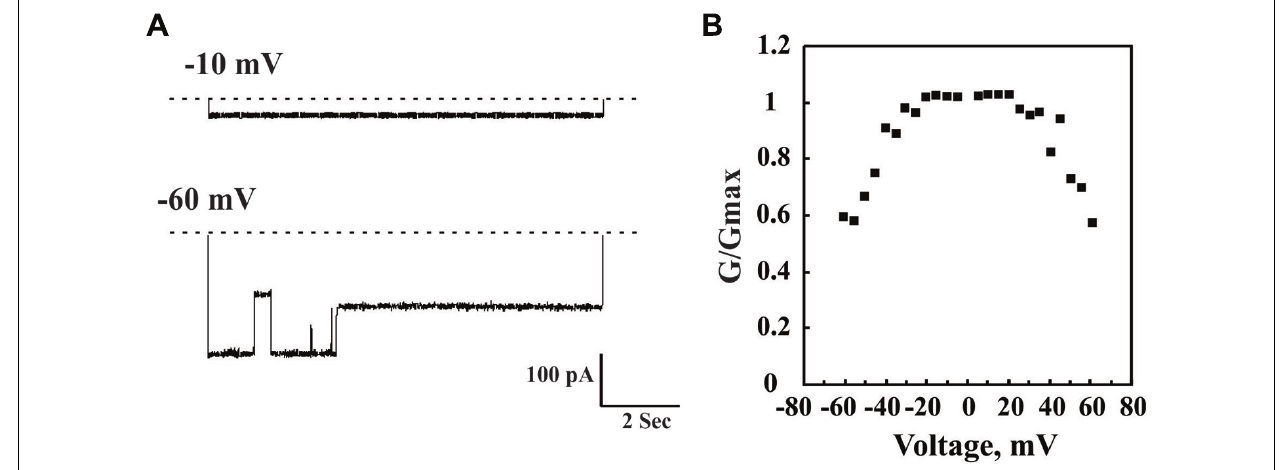
FIGURE 3 | Channel properties of bilayer-reconstituted purifiedVDAC1. Bilayer-reconstitutedVDAC single and multi-channel activity was assayed as described previously (Gincel etal., 2000). PurifiedVDAC (1–5 ng) was reconstituted into a PLB. In (A) , a typical activity recording ofVDAC incorporated into a PLB is presented as current traces obtained in response to voltage steps from 0 mV to either − 10 or − 60 mV. In symmetric solution (1 M NaC), when the voltage was changed from − 0 to 10 mV, the channel opens and remains stable in this conformation for up to 2 h. However, when the voltage was changed from 0 to − 60 mV, the current first increased, due